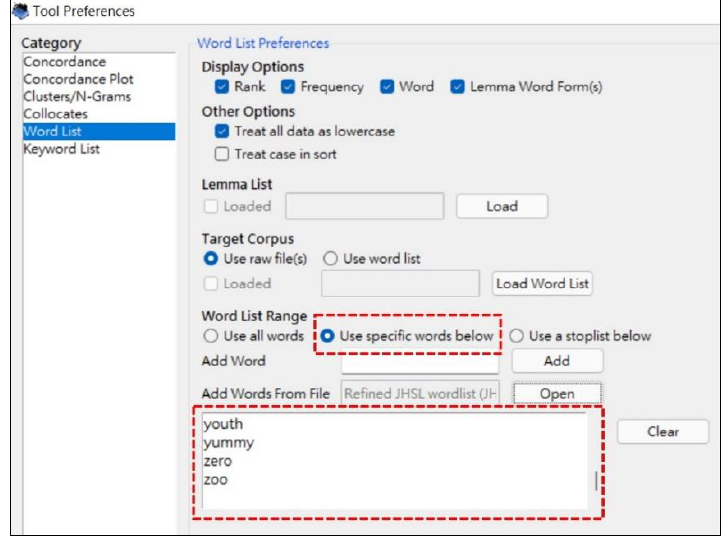
Figure 7. Set CEFR A2 level word list as “specific words”.